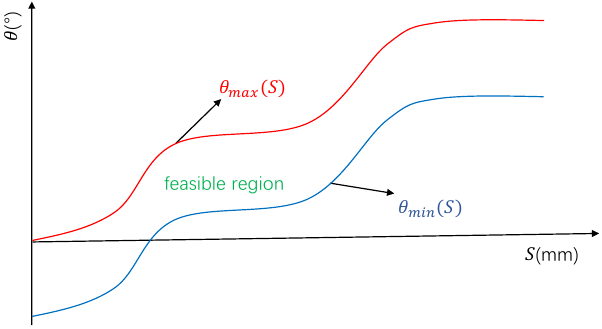
Figure 5. Feasible channel of tool orientation.